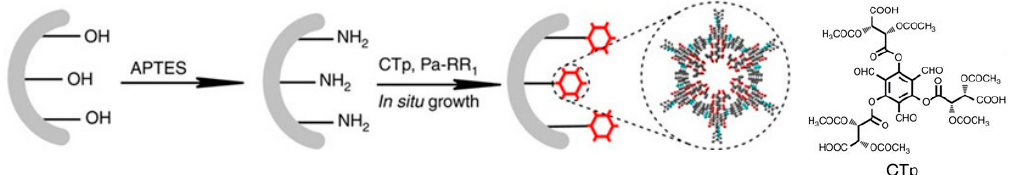
Figure 5. ( a ) Schematic illustration of the synthesis of COF-300@SiO 2 via LBL method; ( b ) powder XRD patterns of COF-300@SiO 2 after different reaction runs; ( c − f ) SEM images of COF-300@SiO 2 after ( c ) 2, ( d ) 3, ( e ) 4, and ( f ) 5 runs. Reproduced from [40] with permission from The Royal Society of Chemistry.